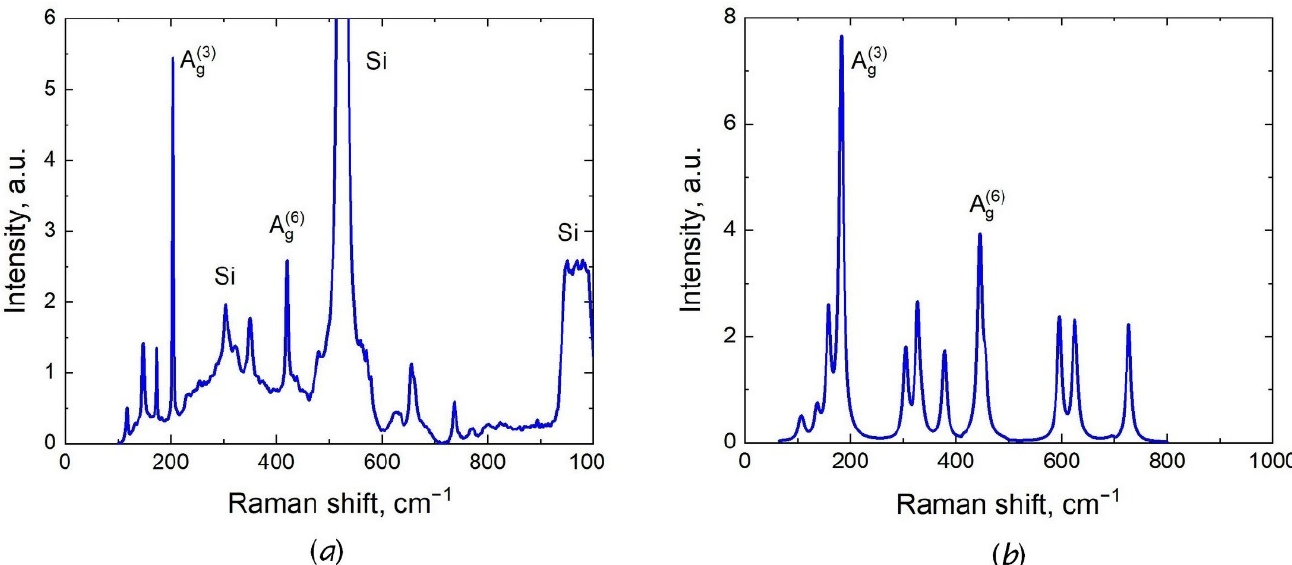
Figure 5. ( a ) The Raman spectrum of 𝛽 -Ga 2 O 3 /SiC/Si in confocal geometry excluding birefringence. Three lines of silicon and two highest lines of 𝛽 -Ga 2 O 3 , namely 𝐴 (cid:3034)((cid:2871)) and 𝐴 (cid:3034)((cid:2874)) , are indicated. ( b ) The theoretical Raman spectrum of 𝛽 -Ga 2 O 3 . The two main lines of the spectrum are marked as 𝐴 (cid:3034)((cid:2871)) and 𝐴 (cid:3034)((cid:2874)) .